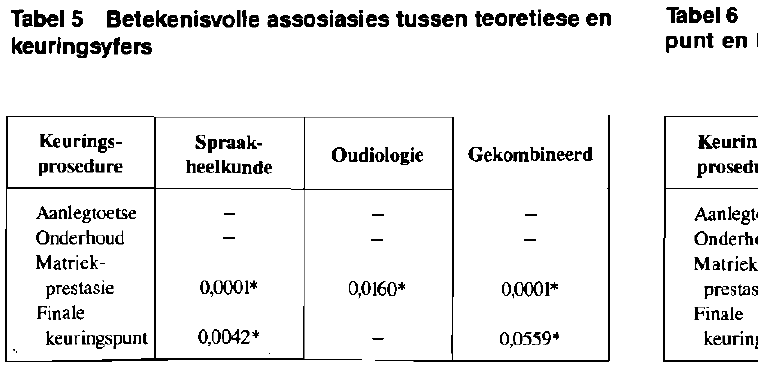
Tabel 6 Betekenisvolle assosiasies tussen praktiese jaar- punt en keuringsyfers